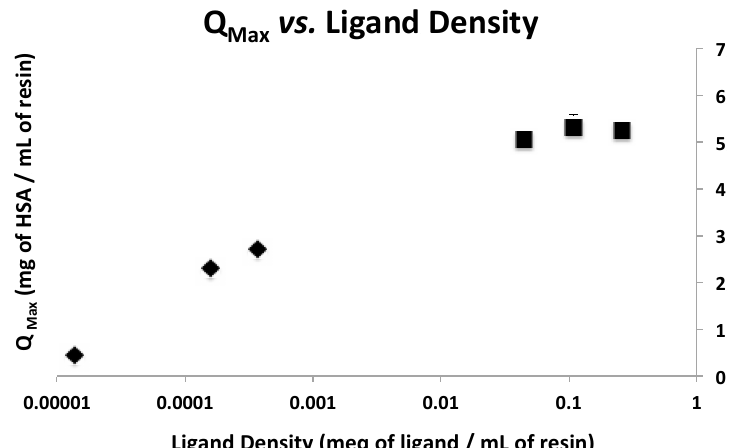
Figure A3. Representation of affibody binding on ( A ) IGKQRI–GSG–Toyopearl vs. ( B ) erbB2– Toyopearl resins. The peptide ligands, target affibody, and protein–affibody complex are in 1:1 molecular scale to each other.